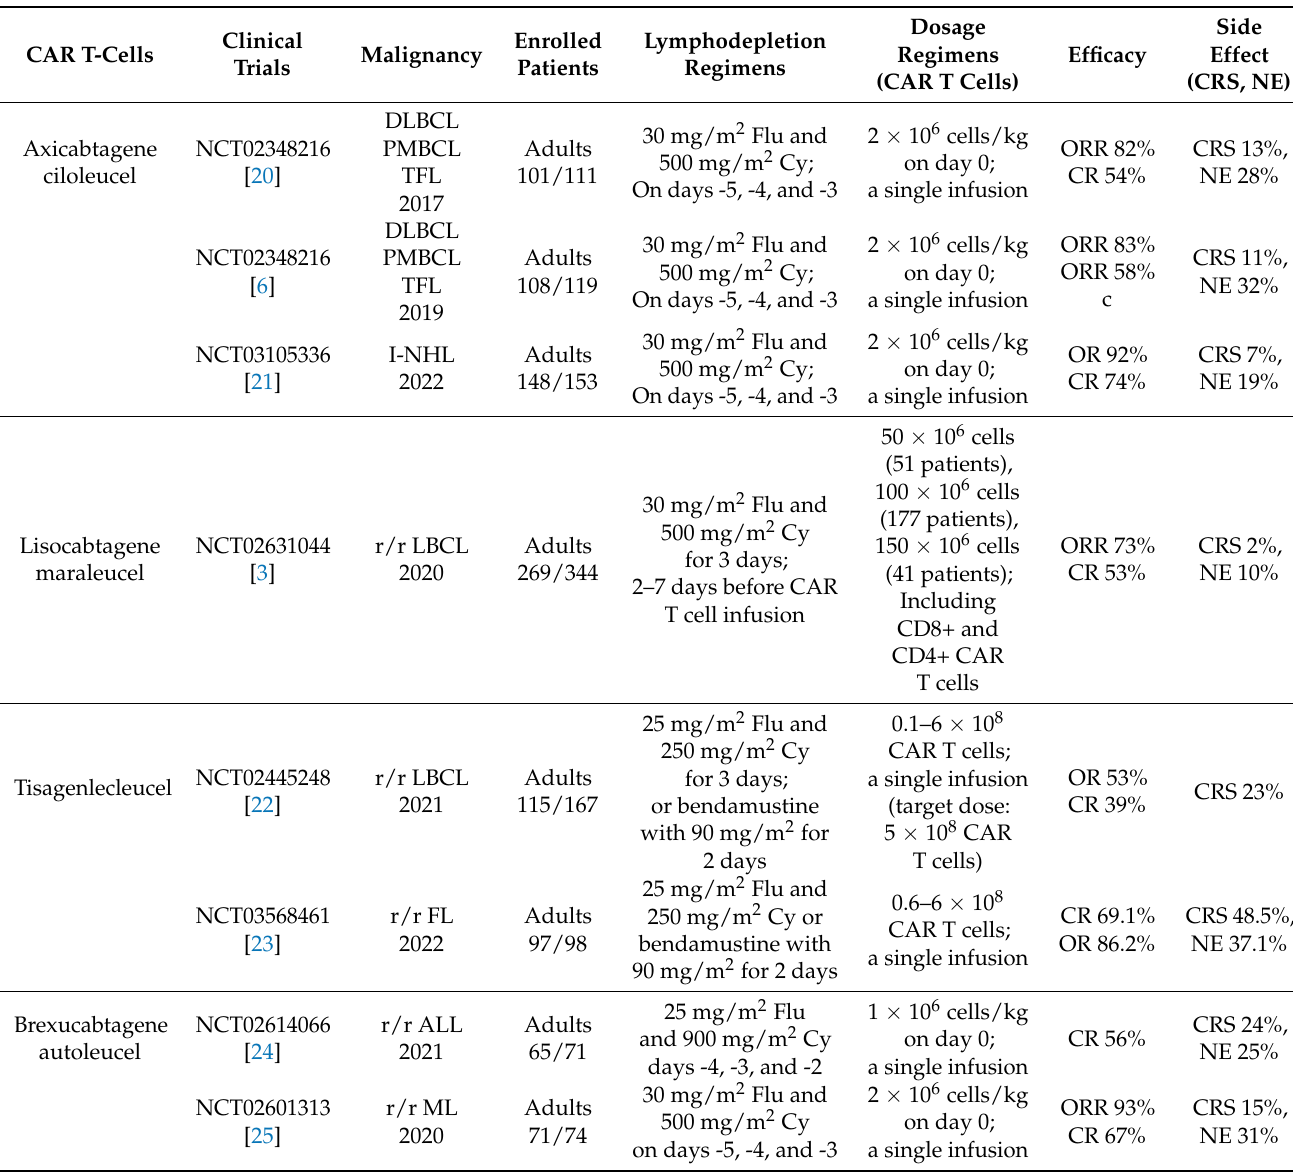
DLBCL = diffuse large B-cell lymphoma; CRS = cytokine release syndrome; NE = neurologic events; I-NHL = indo- lent non-Hodgkin lymphoma; Flu = fludarabine; Cy = cyclophosphamide; OR = overall response; r/r LBCL = re- lapsed or refractory large B-cell lymphomas; r/r FL = relapsed or refractory follicular lymphoma; r/rALL = re- lapsed/refractory acute lymphoblastic leukemia; r/r ML = relapsed or refractory mantle-cell lymphoma; PM- BCL = primary mediastinal B-cell lymphoma; TFL = transformed follicular lymphoma; ORR = objective response rate; CR = complete response